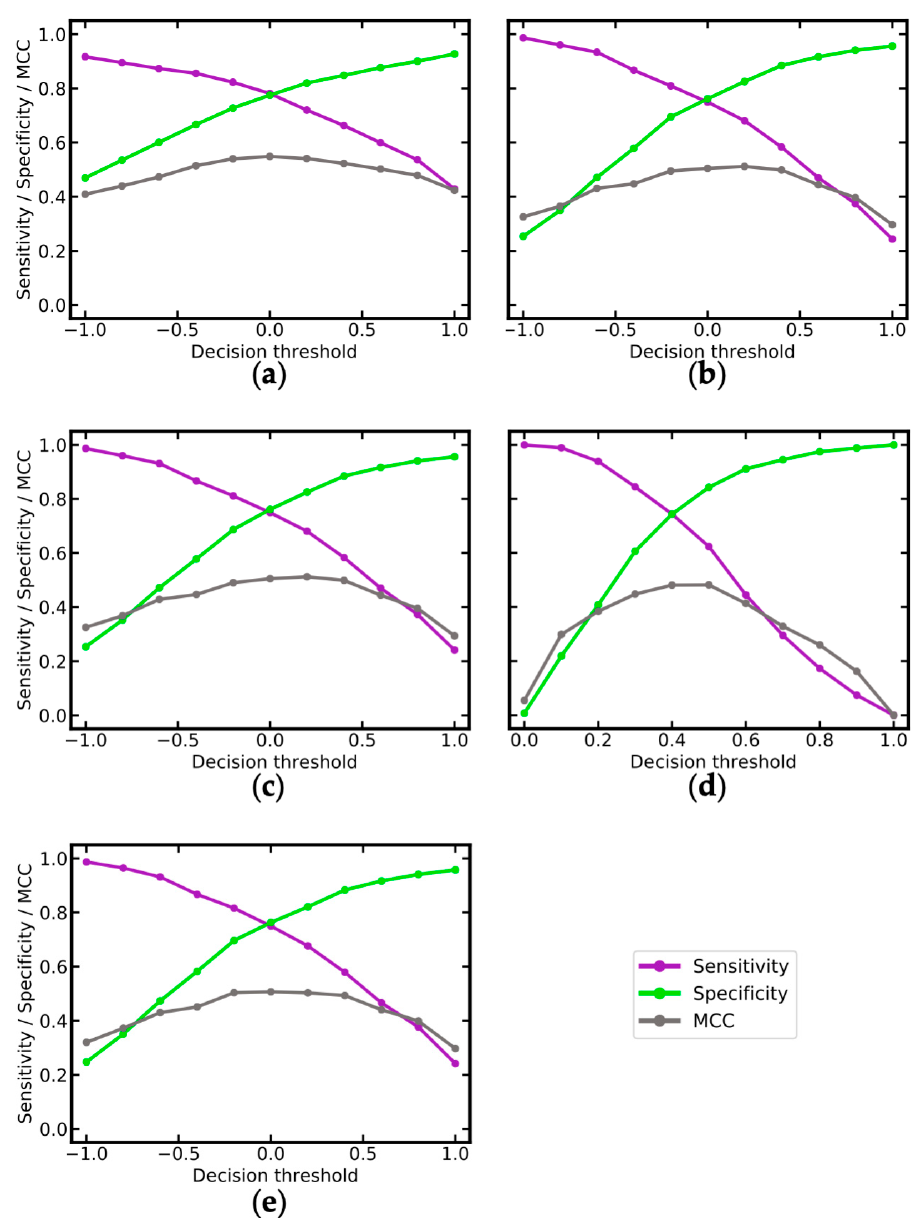
Figure 6. Matthews correlation coefficient ( MCC) as a function of molecular similarity between the query compounds and the one, three and five nearest neighbors in the training data (calculated as averaged Tanimoto coefficients based on MACCS fingerprints). ( a ) SVM_MOE2D+OASIS; ( b ) SVM_PaDEL+OASIS; ( c ) SVM_PaDEL; ( d ) RF_MACCS; ( e ) SVM_PaDEL+MACCS. Pearson correlation coefficients are reported in brackets in the figure legends. The number of compounds in each bin is summarized in Table S7.